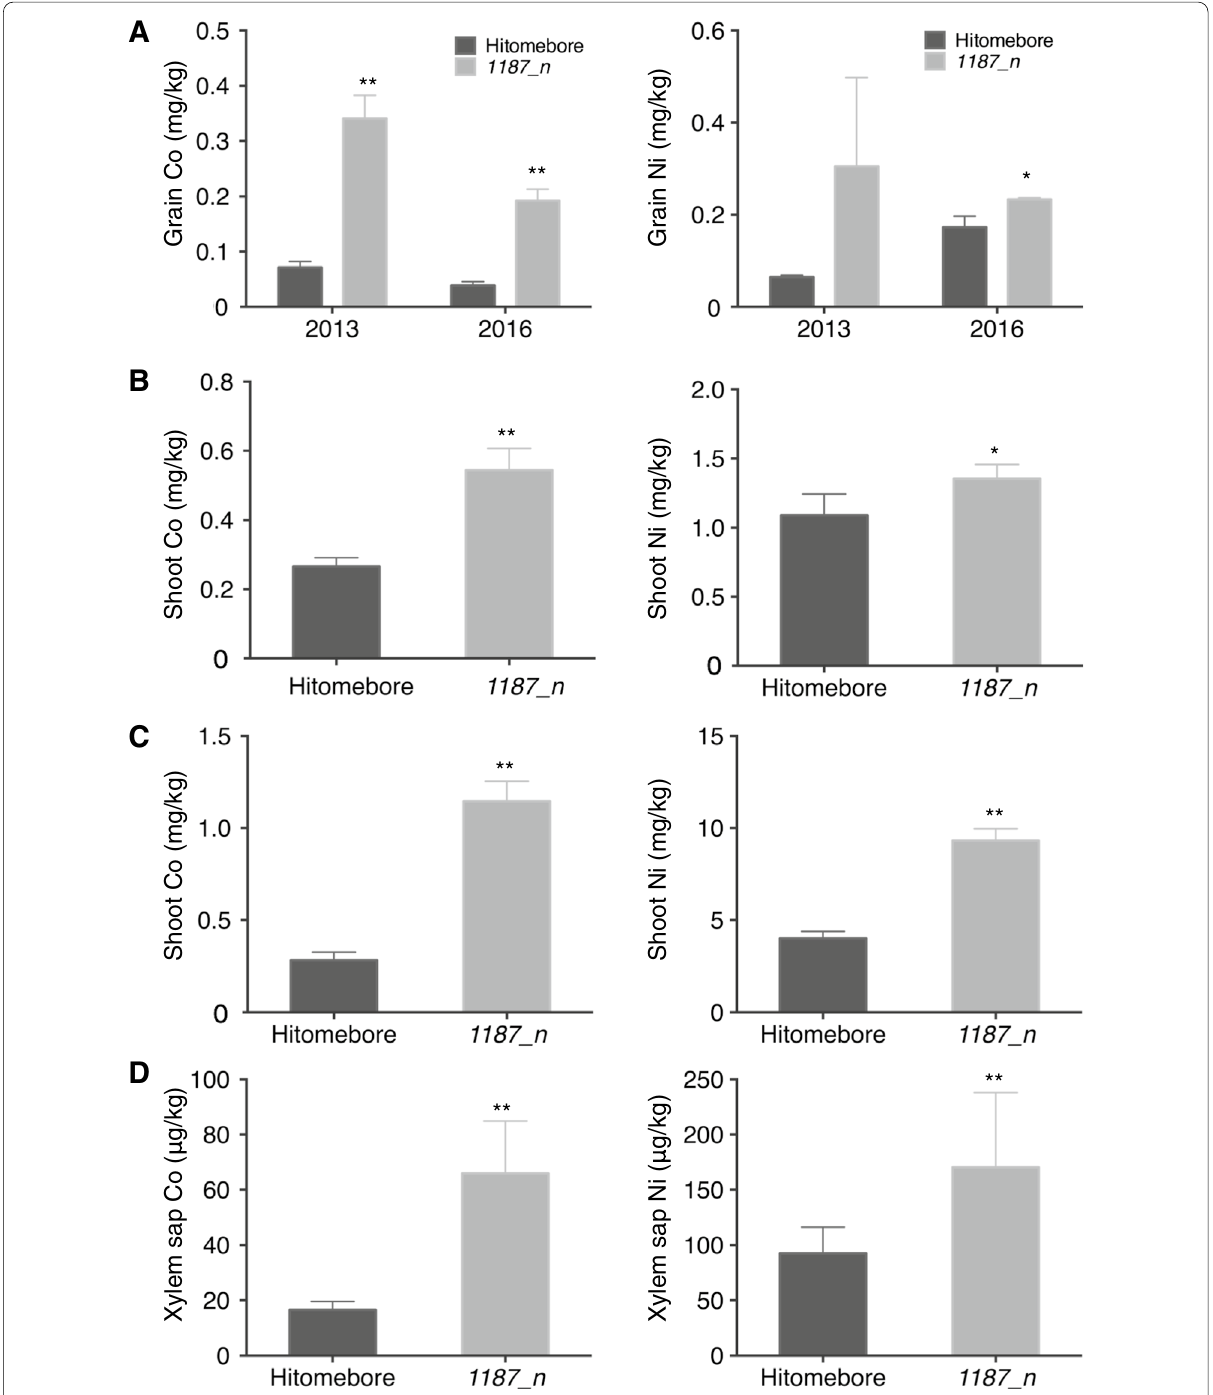
Fig. 1 Co and Ni accumulation in Hitomebore and 1187_n . A Co and Ni concentrations in the grains of Hitomebore and 1187_n grown in a paddy field (n 3–4). B Co and Ni concentrations in the shoots of Hitomebore and 1187_n cultivated in soil (n 3–4). C Co and Ni concentrations in the = = shoots of Hitomebore and 1187_n cultivated in a hydroponic culture (n 11–12). D Co and Ni concentrations in the xylem sap of Hitomebore and = 1187_n cultivated in a hydroponic culture (n 9–11). Xylem sap was collected for 4 h. For A , B data are the same as those in Figure S1. For B – D = 21-d-old seedlings were harvested for the experiments. Data represents the